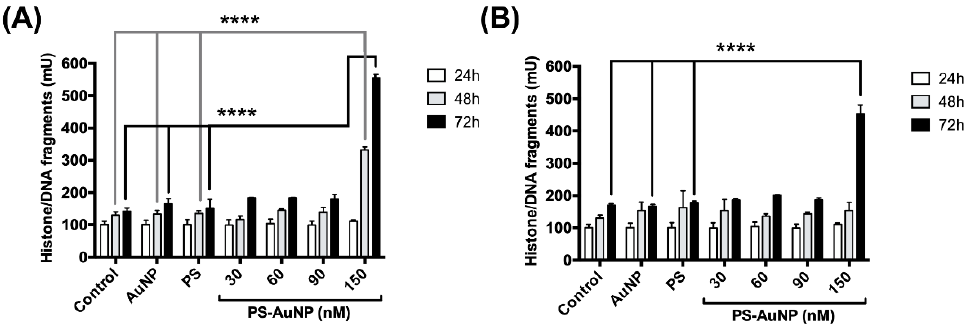
Figure 10. PS-AuNPs induce the formation of Histone/DNA fragments in PC3 ( A ) and MDA-MB-231 ( B ) cell lines. PC3 and MDA-MB-231 cells were challenged for 24 h, 48 h, or 72 h with either PBS (control), 150 nM of AuNP (gold only), 150 nM of PS (lipid only), or a range of PS-AuNP concentrations (from 30 to 150 nM) and tested for the amount of histone/DNA fragments after challenge. **** means p < 0.0001 between the annotated samples.